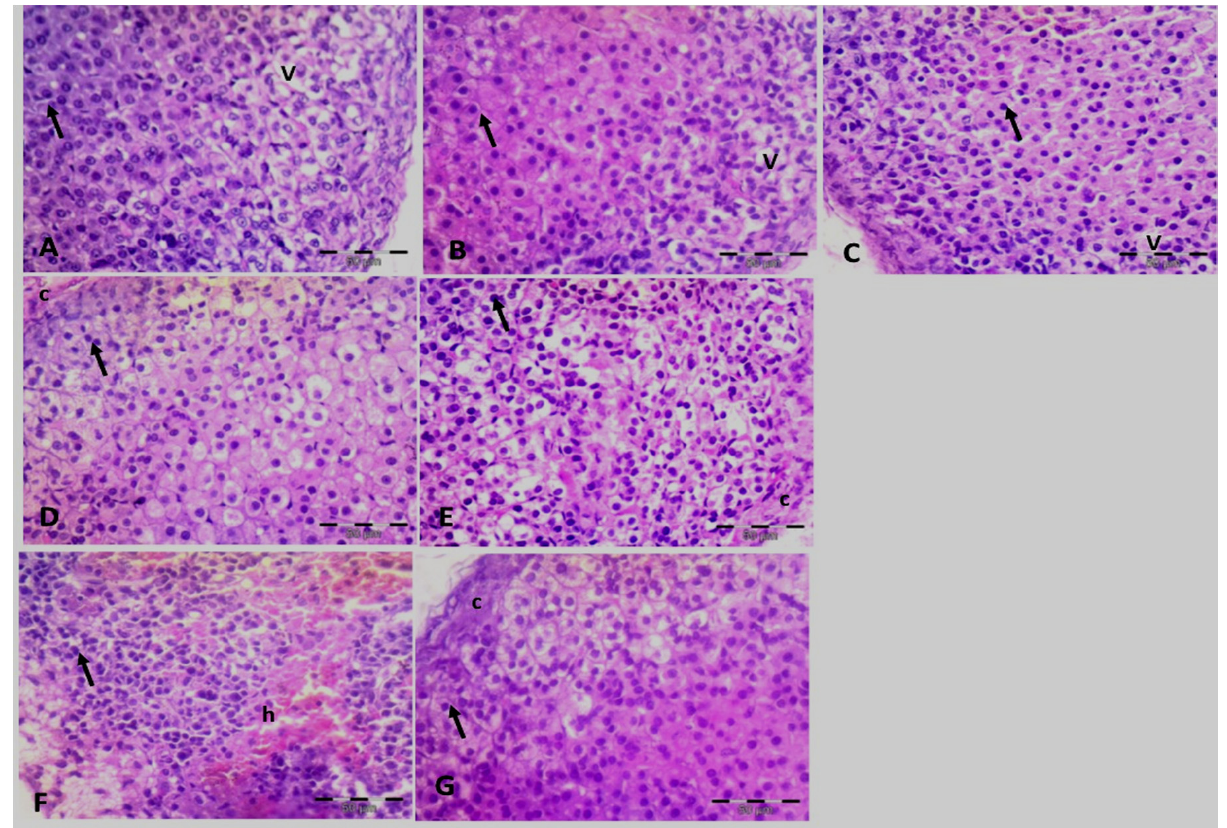
Figure 13. Photomicrographs of the supra renal tissue of ( A – C ): groups 4, 6, and 8, respectively, showing apparent normal supra renal tissue, but vacuolations could still be seen (V). Few dark, dense nucleoli (arrows) could be detected (arrow). ( D,E ) Groups 10 and 7, respectively, showing moderate thickened capsules ( c ). Notice more notable apoptotic cells (arrows) than previously mentioned drugs. ( F,G ) groups 5 and 9 respectively showing severe damage to the suprarenal tissue ( D ). Notice the thicken capsule ( C ) and the hemorrhage ( h ). Notice the more observable apoptotic cells (arrows). H & E × 400.